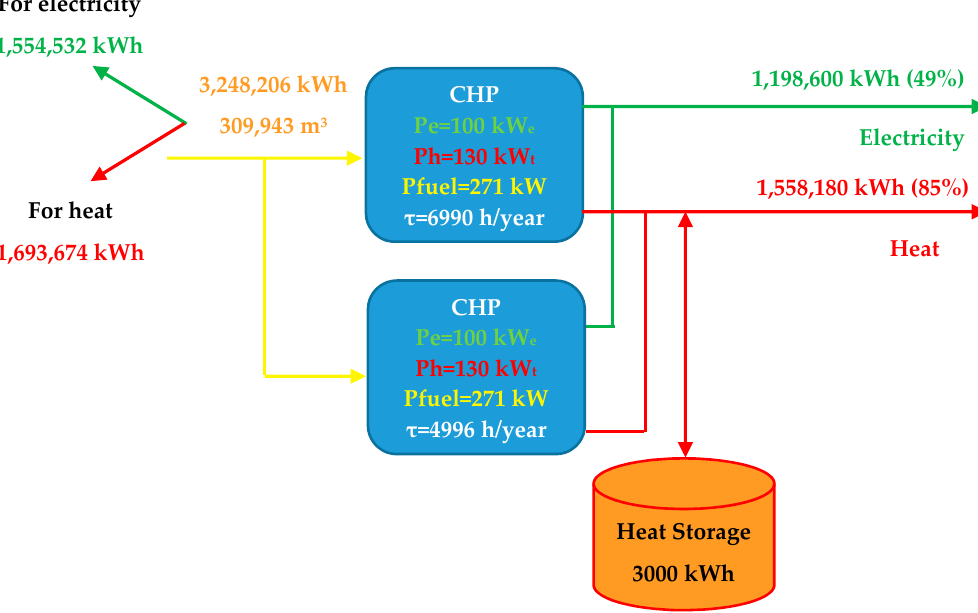
Figure 23. Cogeneration with two units, heat storage, and a peak boiler.